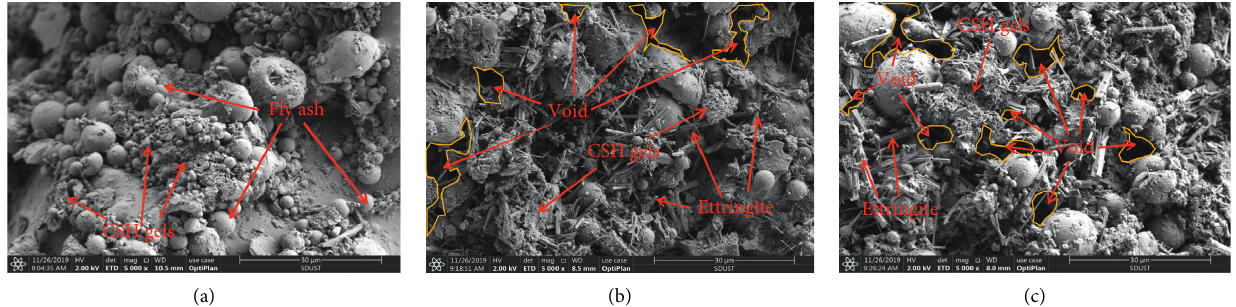
Figure 10: Scanning electron microscopy (SEM) images of different samples cured at 40 ° C for 12 hours: (a) RM, (b) PC, and (c) SC.